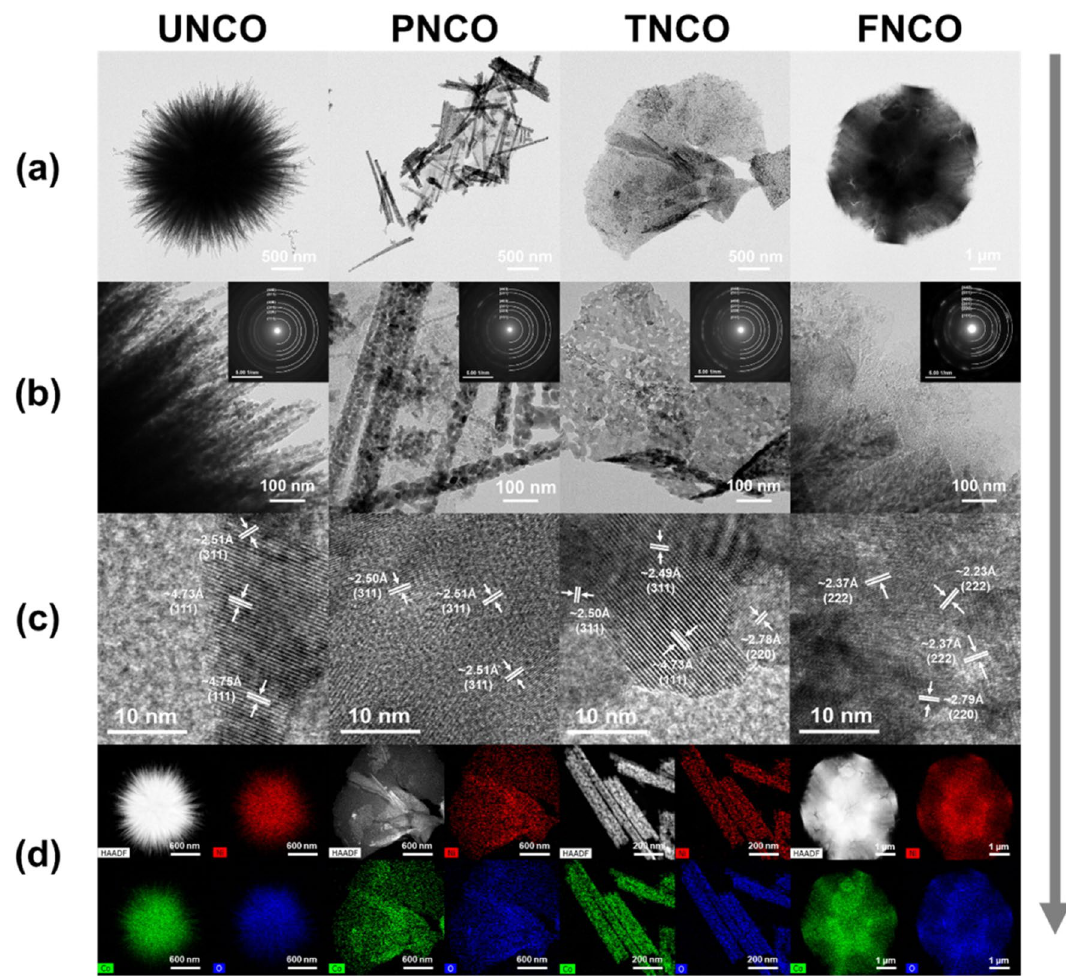
Figure 2. Morphological and structural characterizations of the NCO nanomaterials: ( a ) TEM images, ( b ) TEM images along with the SAED patterns, ( c ) lattice-resolved HRTEM images, and ( d ) corresponding HADDF images of Ni, Co, and O in the NCO